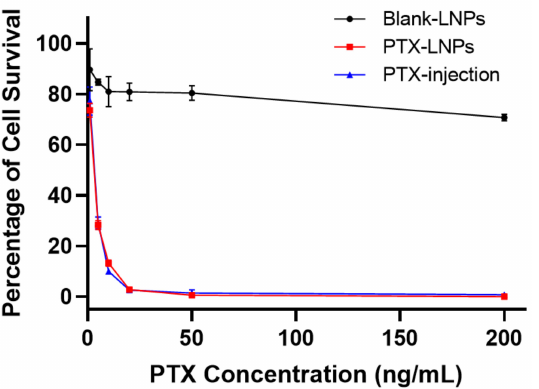
Figure 9. In vitro cytotoxicity evaluation of PTX-LNPs, PTX injection, and blank-LNPs in MDA-MB- 453